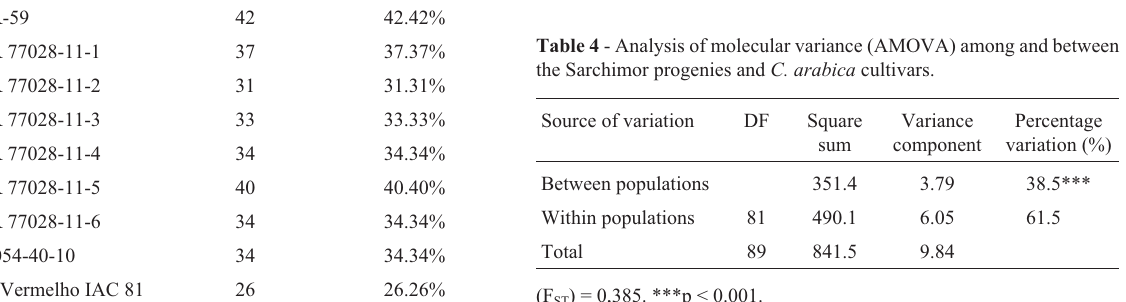
Table 2 - Percentage of polymorphic loci for C. arabica progenies and cultivars estimated according to Yeh et al. (1997). Progenies